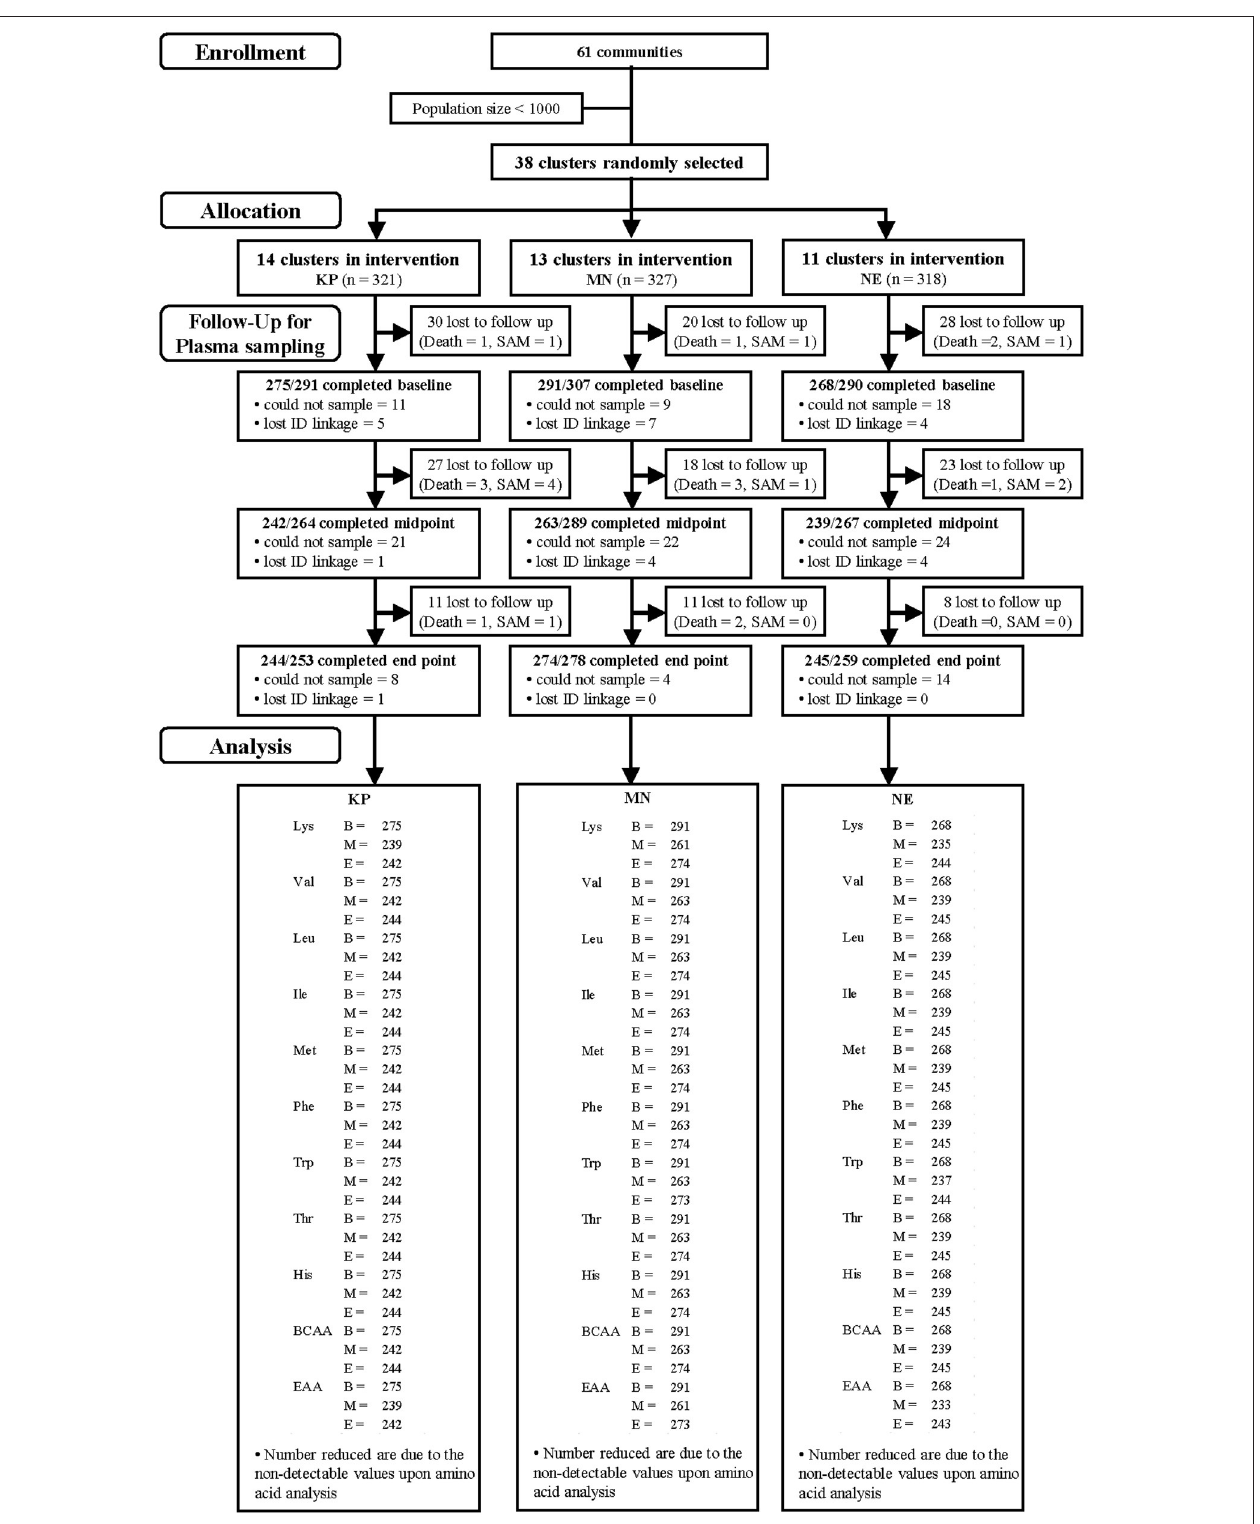
FIGURE 1 | Study participants and follow-up by group [KOKO Plus (KP), micronutrient powder (MN) and nutrition education (NE)]. *Lost to follow-up includes deaths and severe acute malnutrition (SAM).